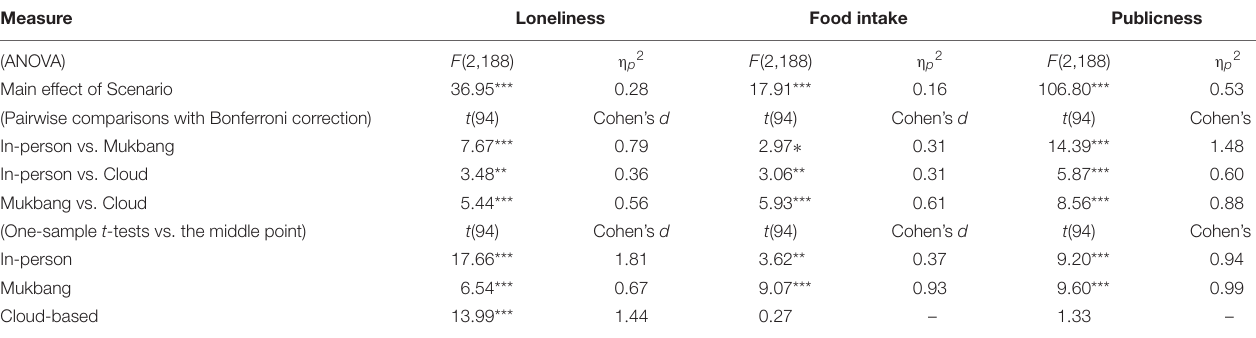
TABLE 1 | The results of ANOVA, pairwise comparisons, and one-sample t -tests performed on the data of scenario ratings. Measure Loneliness Food intake Publicness